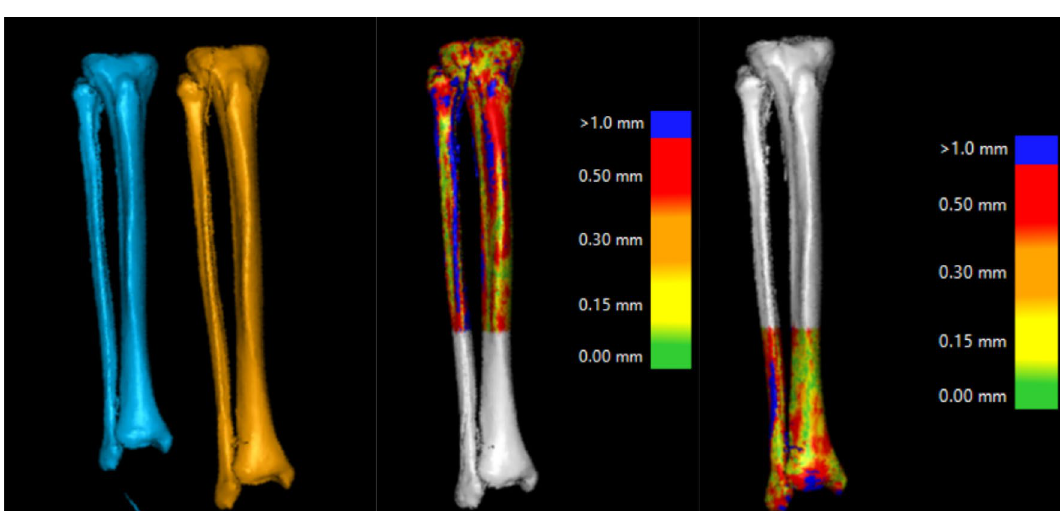
Figure 1. ( A ) Illustrates 3D image of right lower leg. ( B ) Illustrates the mirrored image if the left lower leg. ( C ) Illustrates the left lower leg.